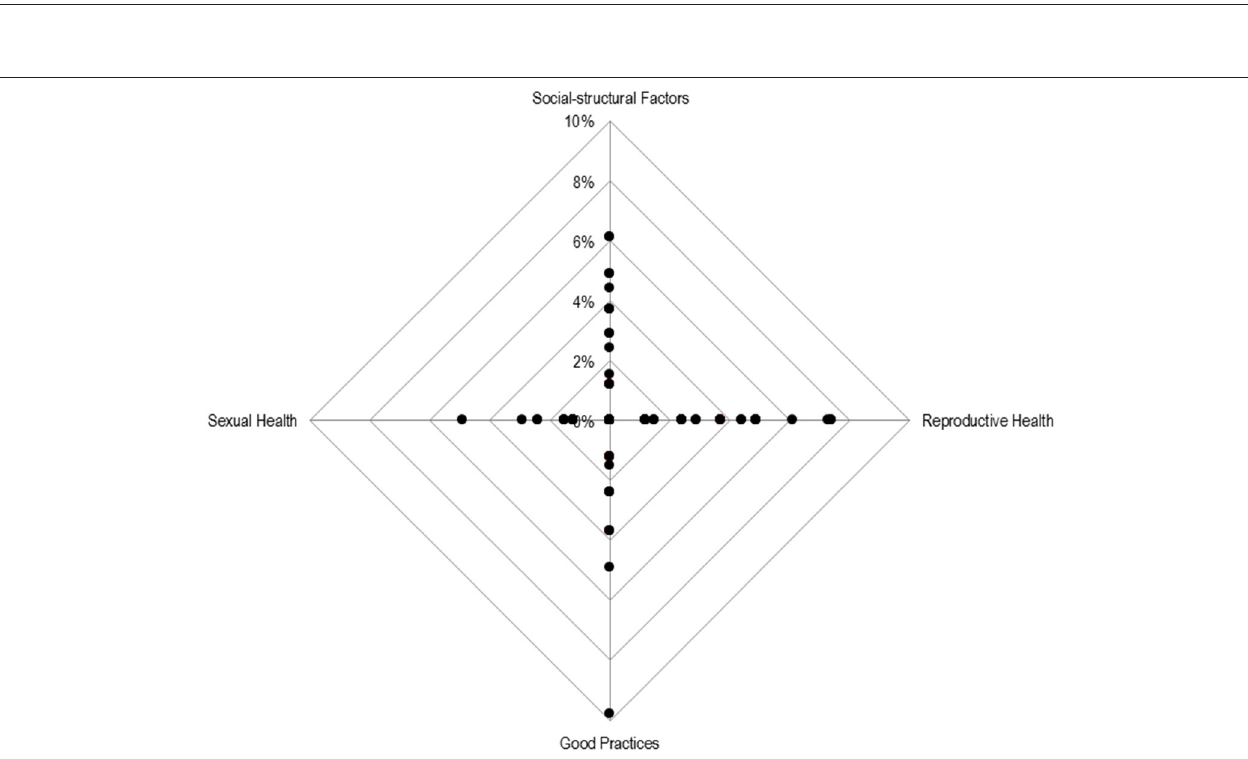
FIGURE 6 | Radar chart for the percentage of no opinions per dimension. Each point represents the percentage of no opinions for each item, per dimension.